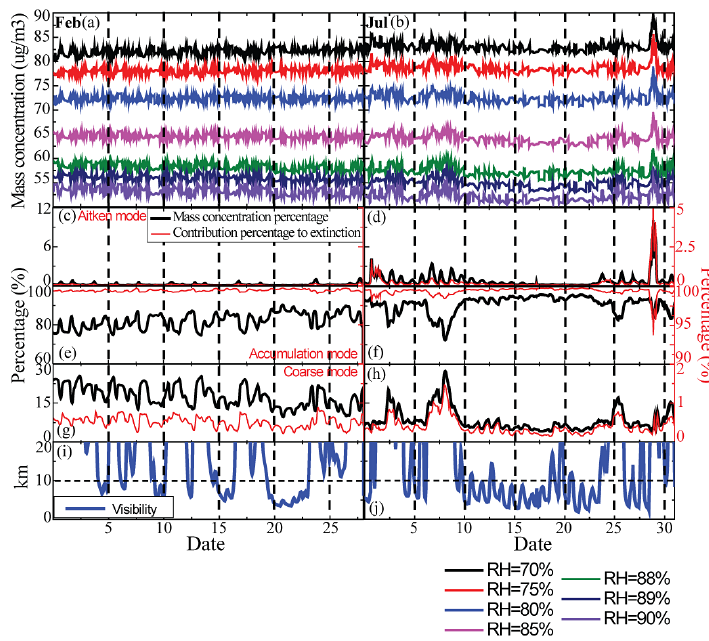
Figure 15. Time series of the regional-average mass concentration threshold of PM 2 . 5 under different relative humidity (%) from the sensi- tivity tests in February and July in Beijing. Also shown are the mass ratios and extinction contribution ratios (%) of the Aitken, accumulation, and coarse modes, and visibility (km).